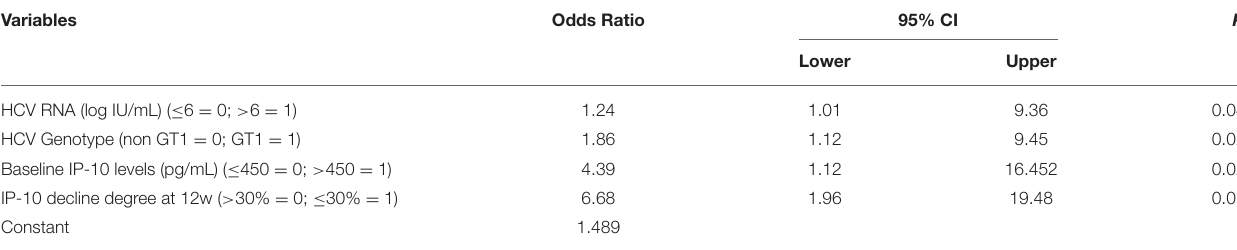
TABLE 2 | Risk factors affecting SVR in HCV-infected patients with PR treatment. Variables Odds Ratio